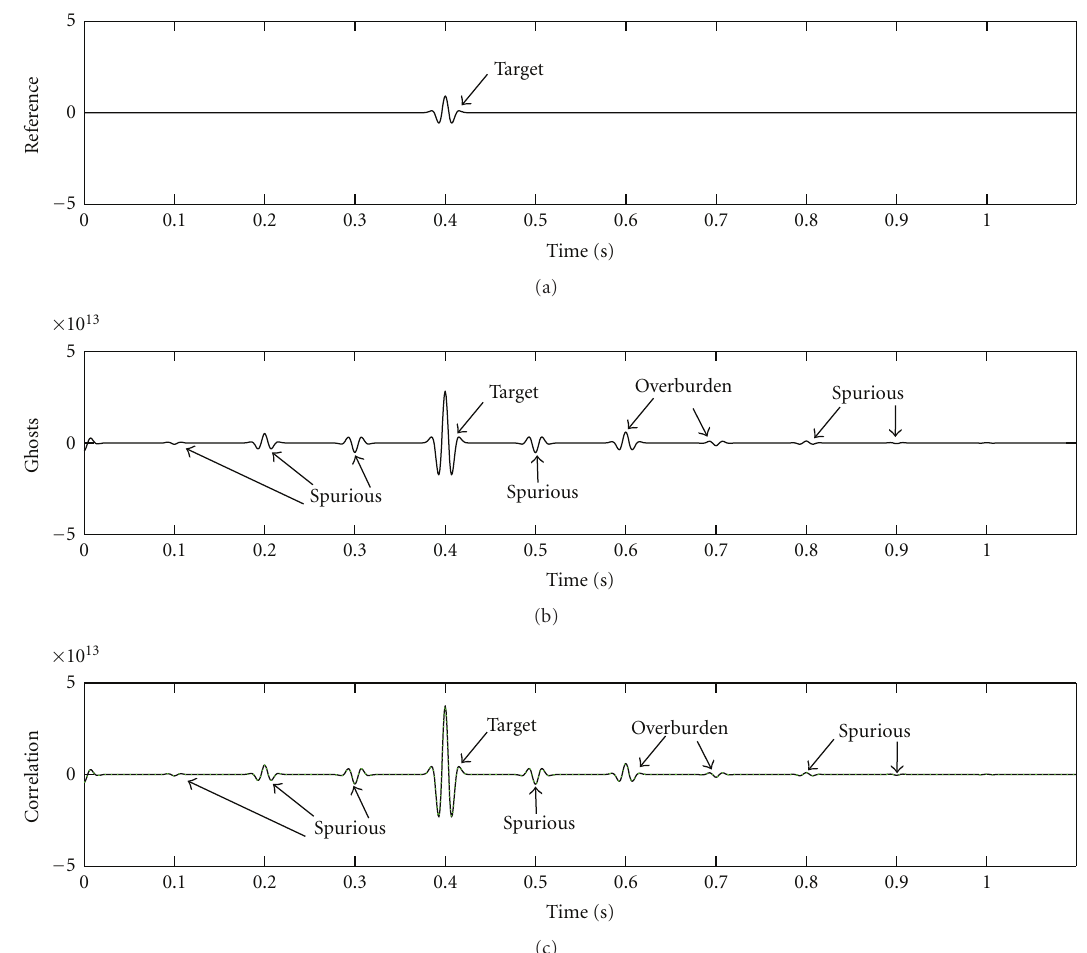
Figure 12: Cross-correlation of decomposed fields for model D: (a) reference response by placing an active source at the virtual source location x A ; (b) computed ghost terms g S